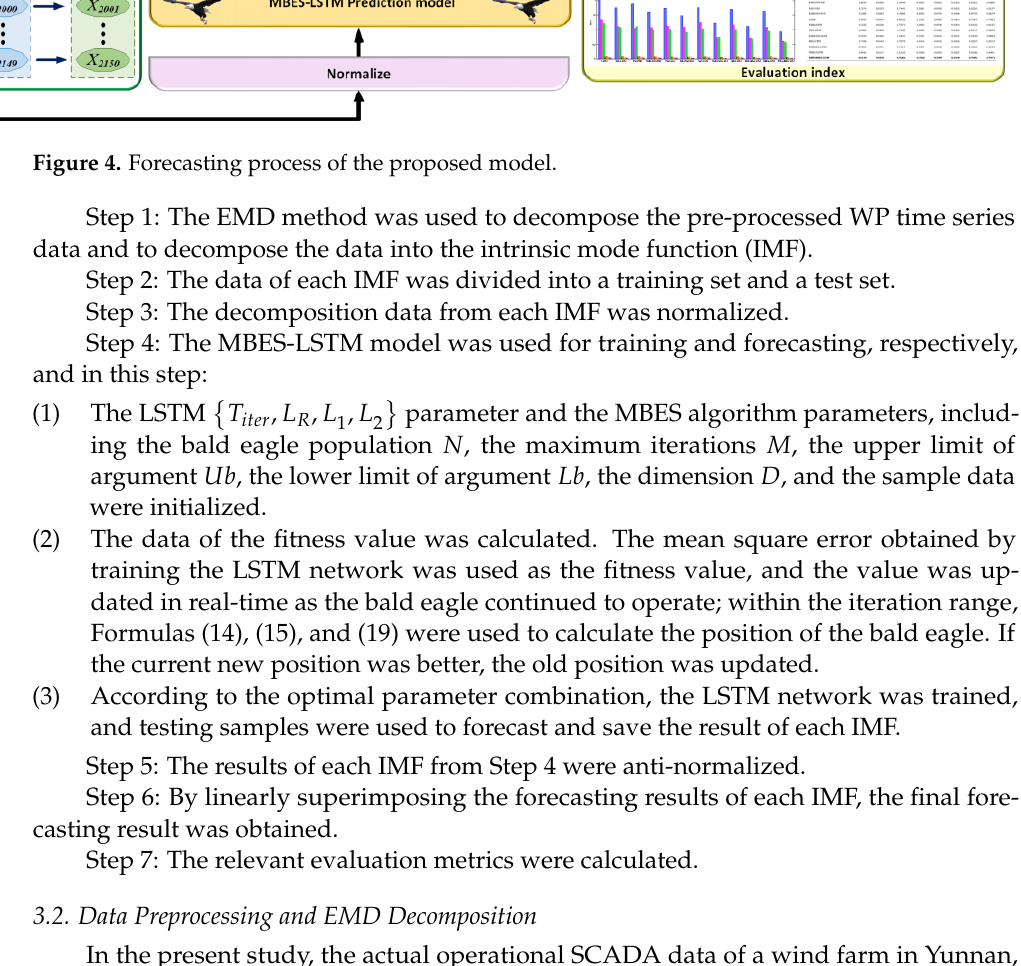
Table 6. Attributes of training set and test set samples.